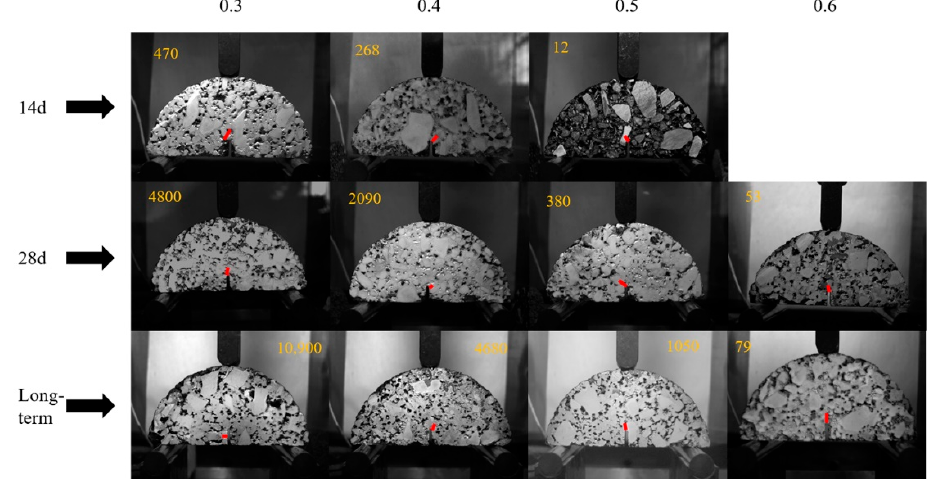
Figure 8. The position of the initial cracking point with different stress ration.